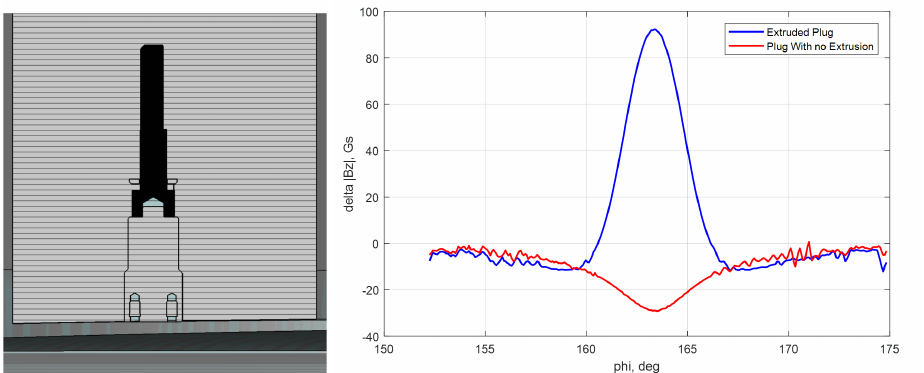
Figure 3. Left: Cross-section of the screw inserted into a sector, covered with the plug. Right: The impact of the screw on the magnetic field distribution versus angle, on the radius that crosses its center.